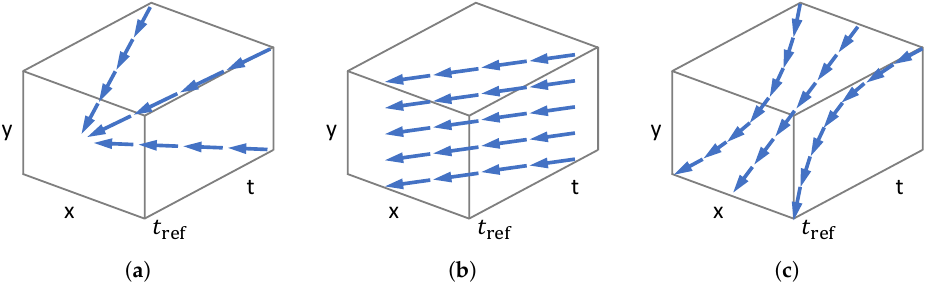
Figure 3. Point trajectories (streamlines) defined on x − y − t image space by various warps. ( a ) Zoom in/out warp from image center (1 DOF). ( b ) Constant image velocity warp (2 DOF). ( c ) Rotational warp around X axis (3